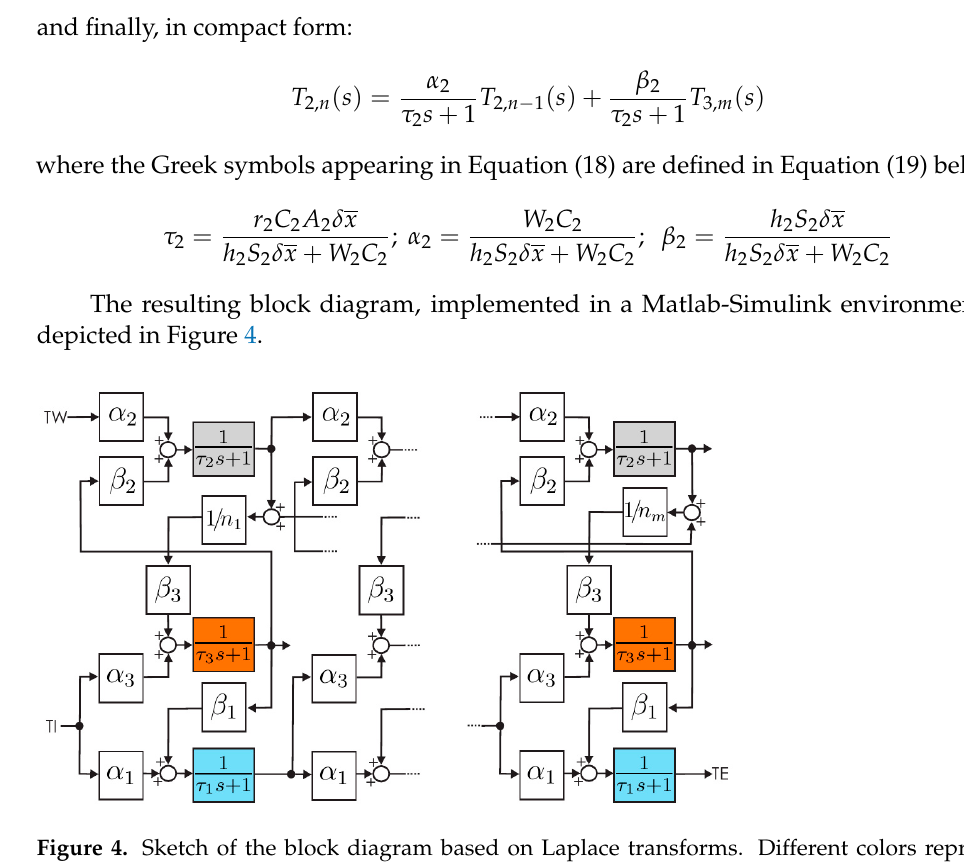
Figure 4. Sketch of the block diagram based on Laplace transforms. Different colors represent respectively water (grey), copper (orange) and air (cyan).